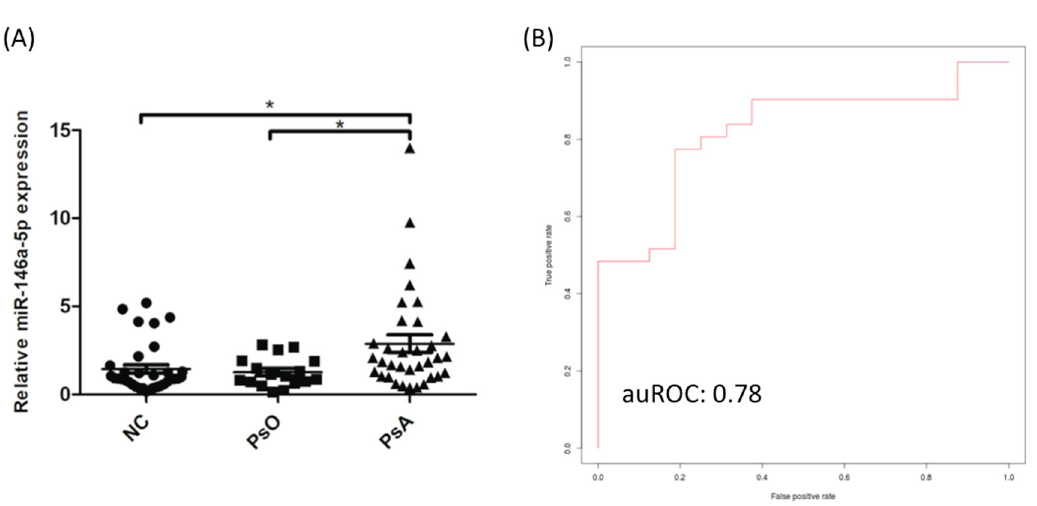
Figure 2. Increased expression of miR-146a-5p in CD14 + monocytes from PsA patients, validation by qRT-PCR ( A ), and demonstration of utility by support vector machine analysis ( B ). ( A ) The expression levels of miR-146a-5p were measured in NCs ( n = 34), PsO patients ( n = 17) and PsA patients ( n = 34) by qRT-PCR. Patients with PsA showed increased expression of miR-146a-5p in CD14 + monocytes. ( B ) The Support Vector Machine (SVM) learning algorithm was used to distinguish PsA from NC. To diagnose PsA, a training model was generated by measuring miR-146a-5p expression in CD14 + monocytes from patients with PsA and NCs. The auROC was 0.78, indicating that miR-146a-5p expression can distinguish PsA patients from NCs with high accuracy. * p < 0.05.